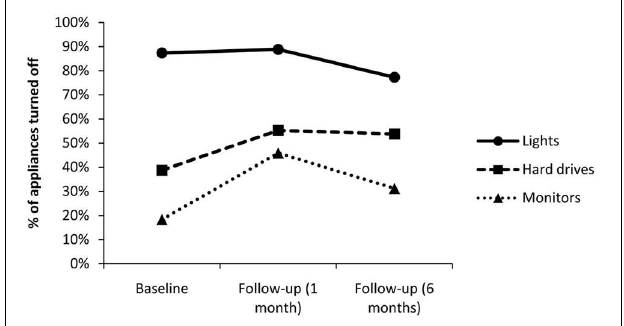
FIGURE 2 | Findings from the energy